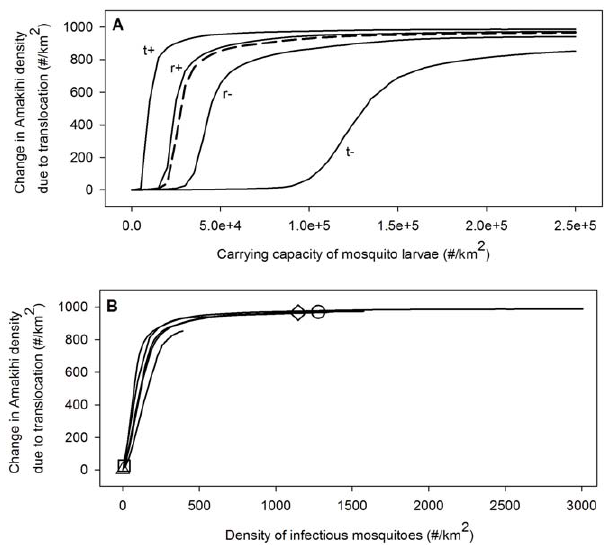
Figure 6. The change in mean annual densities of Amakihi at mid-elevation due to the translocation of disease-resistant Amakihi as a function of larval carrying capacity and density of infectious mosquitoes for different mid-elevation climate scenarios. The dotted line represents a climate with a mean annual temperature of 17 u C and an average yearly rainfall of 3000 mm. The other climate scenarios are derived from this scenario by increasing or decreasing the daily temperatures and rainfall. The mean annual temperatures and average yearly amounts of rainfall for these scenarios are 15.5 u C and 3000 mm (t 2 ), 18.5 u C and 3000 mm (t + ), 17 u C and 2000 mm (r 2 ) and 17 u C and 4000 mm (r + ). The markers in the bottom figure indicate the mean annual bird densities at the biocomplexity field sites: circle=Waiakea, diamond=Cooper, square=Crater and